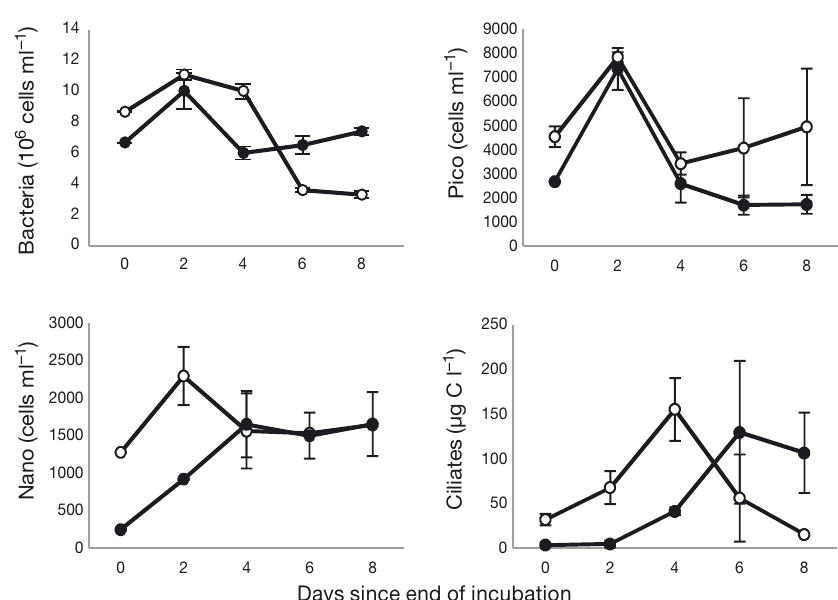
Fig. 2. Mean ± SD concentrations during the recovery period for bacteria, picophy- toplankton, nanophytoplankton and ciliates. The x -axis indicates the days since the filtration experiment had ended; Day 8 marks the end of the recovery period. White symbols indicate the controls; black symbols indicate the blue mussel Mytilus edulis treatment. For this example, data from 7 September 2011 were used